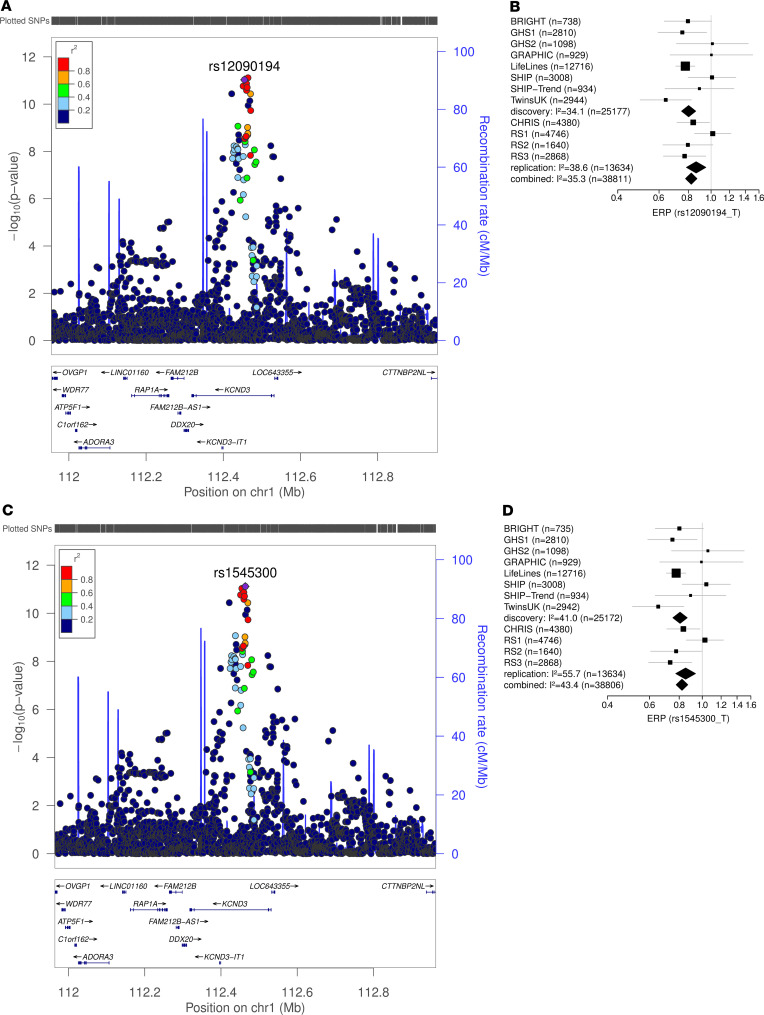
GWAS results for the KCND3 locus.The results of the combined early repolarization pattern (ERP) GWAS results for the KCND3 locus are shown for the replicated discovery-stage lead SNP rs12090194 in n = 38,811 individuals (A and B) and for the combined GWAS lead SNP rs1545300 in n = 38,806 individuals (C and D). The regional association plots (A and C) show the association results in a ±500-kb region around the lead SNP. SNPs are plotted on the x axis according to their chromosomal position with the –log10(P value) of the GWAS association on the y axis. Correlation with the lead SNP (purple) is estimated based on the 1000 Genomes reference samples. Plots were generated using the LocusZoom website (54). Genetic positions refer to GRCh37/hg19 coordinates. Forest plots of the respective lead SNPs are provided in B and D, with ORs and their 95% confidence intervals plotted on the x axis. I2 is the percentage of total variation across studies that is due to heterogeneity.